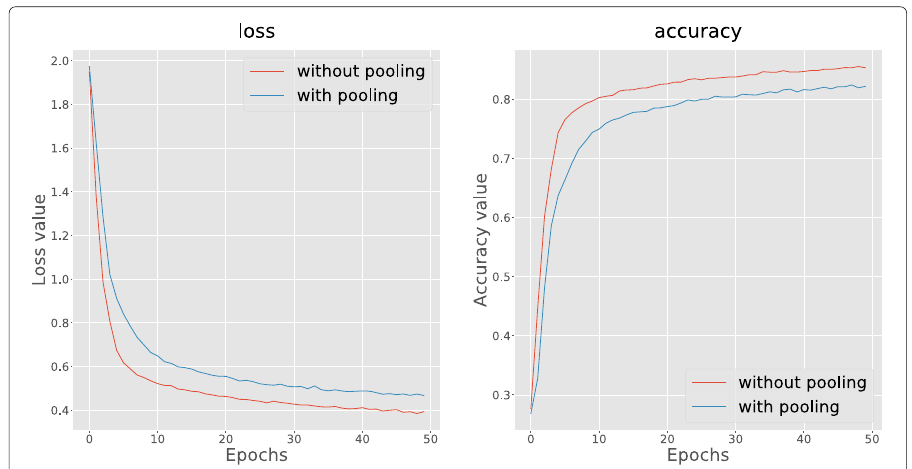
Fig. 18 The loss and accuracy are from the first 50 epochs between using the max-pooling layer and without using the max-pooling